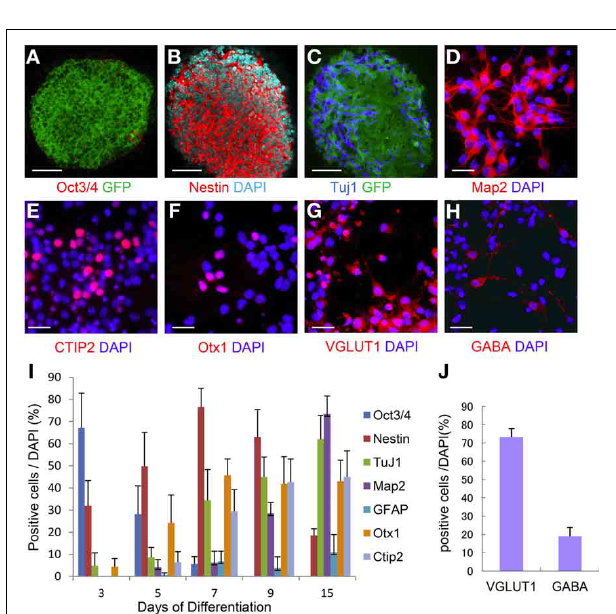
FIGURE 3 | Time course of ES cell neural induction with MS5 co-culture. Colonies of ES cells grown on MS5 cells for 7 days were immunostained for Oct3/4 (A) and GFP, nestin (B) , Tuj1 (C) , and GFP. Immunostaining of day 7 MS5-NPCs after an additional 8 days of differentiation into mature cells on polyornithine/fibronectin (OF)-coated slides, Map2ab (D) , Ctip2 (E) , Otx1 (F) , VGLUT1 (G) , and GABA (H) . (I) Time course of immunostaining for Oct3/4- Nestin-, TuJ1-, Map2ab-, GFAP-, Otx1-, and Ctip2-positive cells as a percentage of total DAPI-stained cells. (J) Frequency distribution of glutamatergic and GABAergic neuronal markers as a percentage of total DAPI stained cells after 15 days of neuronal differentiation. Scale bar; (A–C) , 50um; (D–H) , 25um.